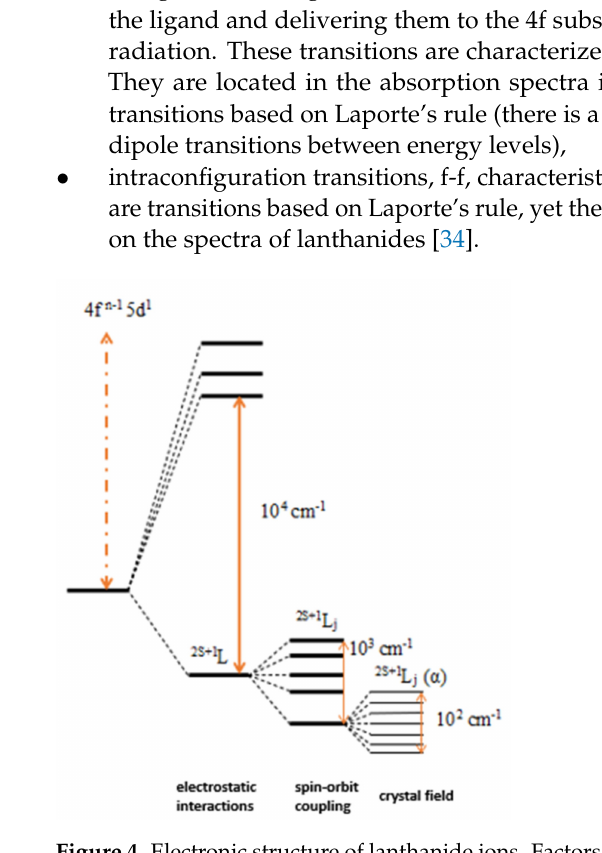
Figure 4. Electronic structure of lanthanide ions. Factors influencing the destruction of levels together with the values of splitting: electrostatic interactions, spin–orbit coupling and crystal